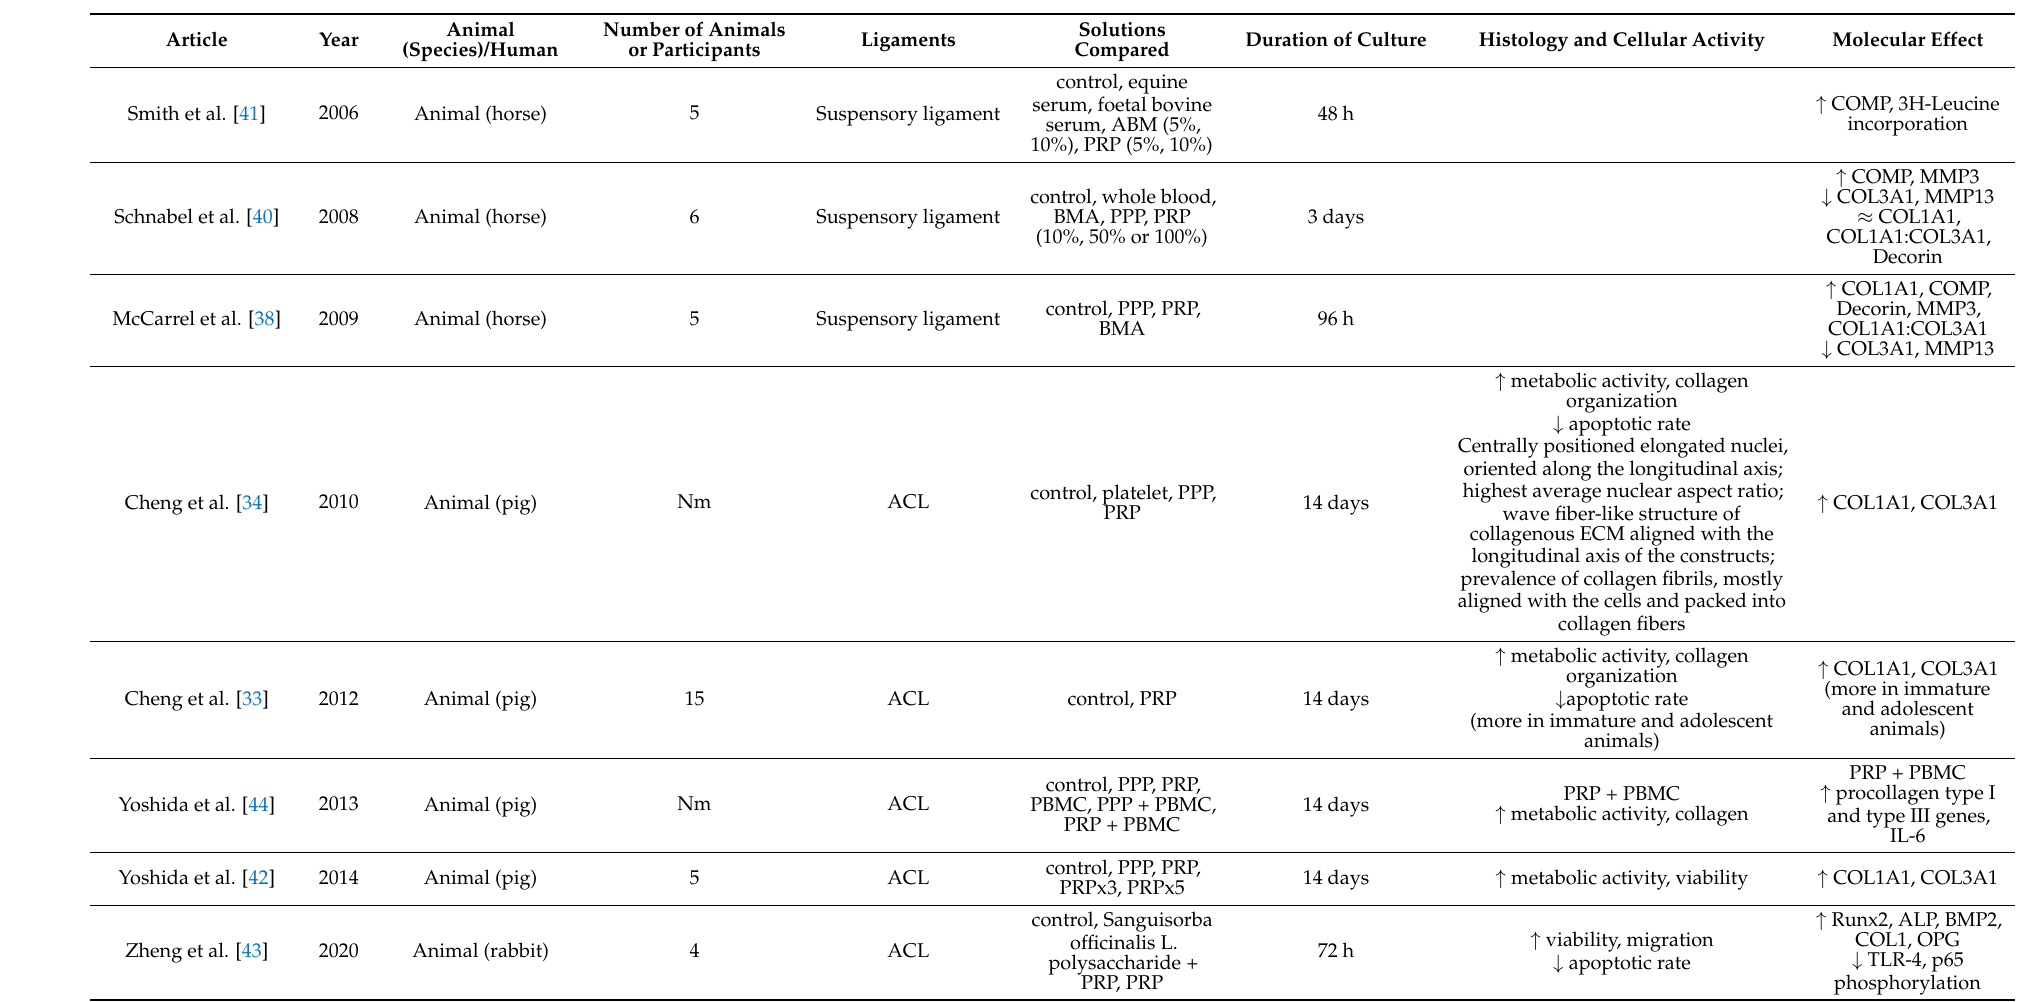
Table 1. Histological and molecular effect of PRP on ligaments in in vitro